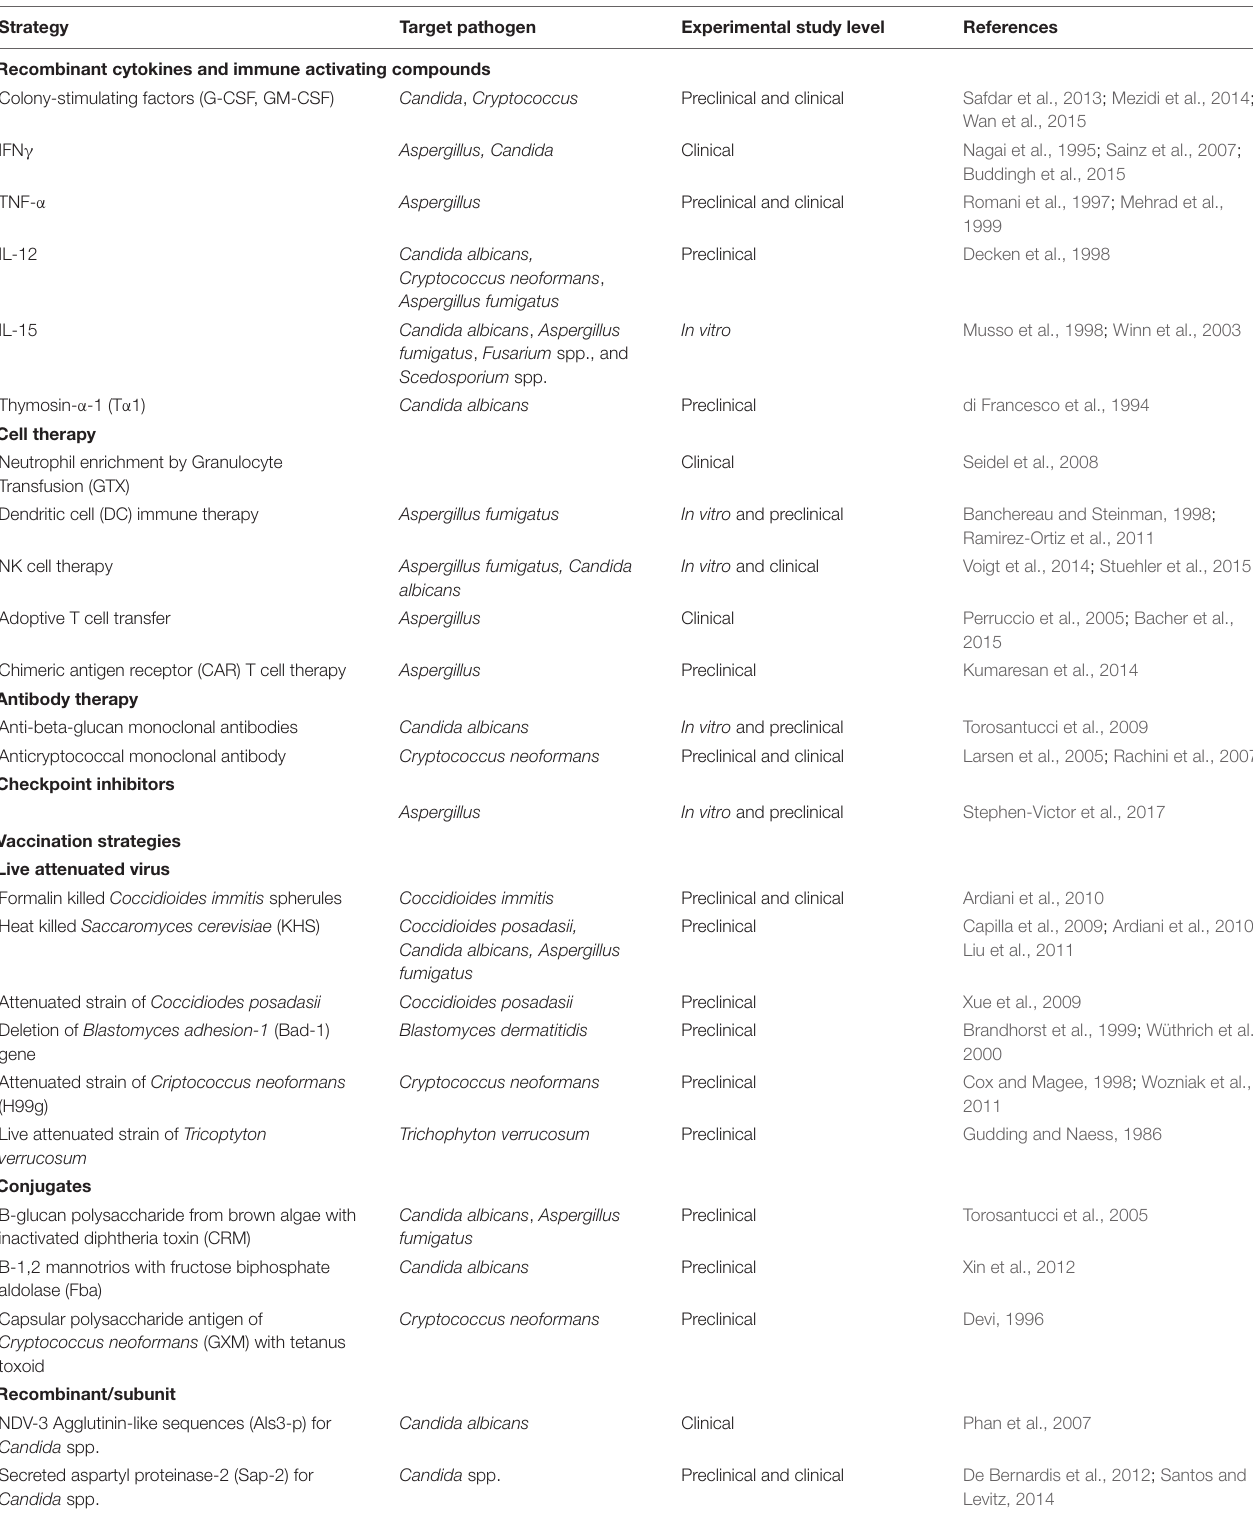
TABLE 1 | Summary of the attempted immunotherapies to